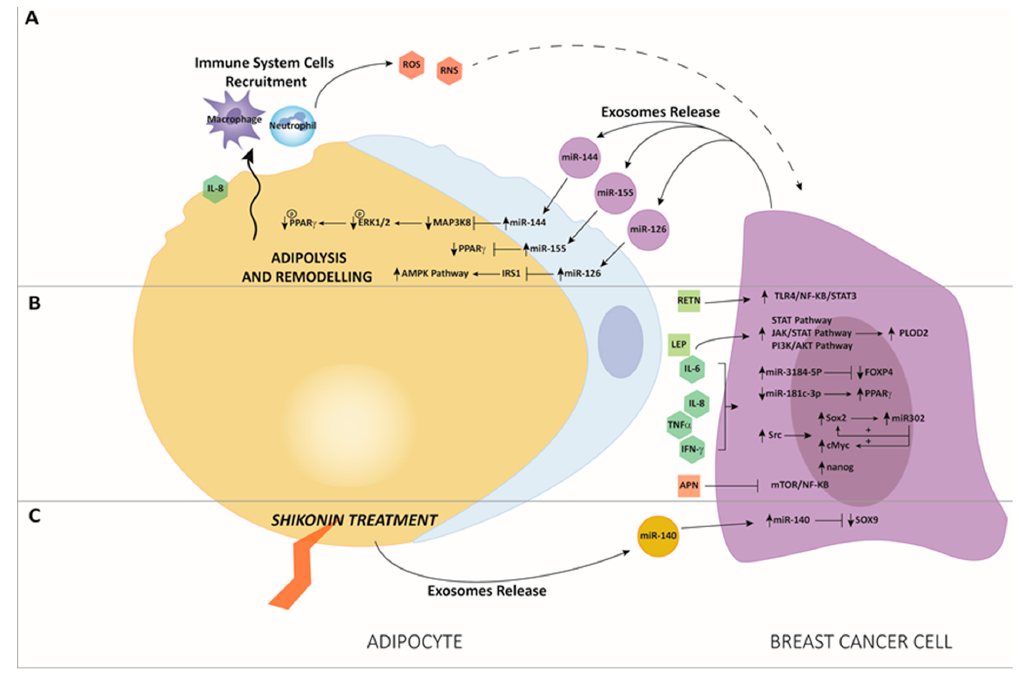
Figure 2. ( A ) After co-culture between adipocytes and breast cancer (BC) cells, high levels of miR-144 and miR-126 were released by exosomes by BC cells. This miRs delivery leads to final adipolysis and remodeling of adipose tissue driven by miR-144 through the downregulation of Mitogen-Activated Protein Kinase Kinase Kinase 8 / Mitogen-Activated Protein Kinase 3 / 1 / Peroxisome Proliferator Activated Receptor Gamma (MAPK3 / ERK1 / 2 / pPPAR γ ) and by miR-126 through the Protein Kinase AMP-Activated Catalytic Subunit Alpha 1 (AMPK) / autophagy pathway, causing adipocyte-induced tumor growth [77]. BC-derived exosomes after adipocytes interaction carry a higher level of miR-155, which promotes adipocytes di ff erentiation and remodeling in surrounding adipocytes targeting pPPAR γ , thus facilitating tumor progression [76]. Increased adipocyte-derived interleukin-8 (IL-8) is responsible for neutrophils and macrophages recruitment, leading to the production of Reactive Oxygen Species (ROS) and Reactive Nitrogen Species (RNS), which act as a threat to tumor initiation. ( B ) Interaction of adipocytes with BC cells increase the release of proinflammatory cytokines and chemokines, leading to an upregulation of miR-3184-5p and downregulation of miR-181c-3p in BC cells, with the modulation of their respective target genes, forkhead box P4 (FOXP4) and PPAR α ; increased release of adipocyte-derived proinflammatory cytokines and adipokins such as leptin (LEP), IL-6, IL-8 and tumor necrosis factor alpha (TNF α ) is responsible for the induction of janus kinase / signal transducers and activators of transcription (JAK / STAT) and through phosphoinositide 3-kinase / protein kinase B (PIK3 / AKT) pathways. Resistin (RETN) promotes BC progression through the Toll like receptor 4 / nuclear factor kappa-light-chain-enhancer of activated B cells / signal transducer and activator of transcription 3 (TLR4 / NF- κ B / STAT3) axis. As a result, EMT, migration and invasion pathways are enhanced in BC cells [72]. Likewise, after adipocytes and BC cells co-culture, there is an increase of proinflammatory cytokines secretion, with an activation of Src that upregulates SRY-Box transcription factor 2 (SOX2), cMYC and Nanog. SOX2 induces miR-302b transcription that, in turn, further stimulates cMYC and SOX2 expression, increasing the cytokine-induced cancer stem cell-like properties [73]. Conversely, adiponectin (APN) has anti-tumoral properties by inhibiting mammalian target of rapamycin (mTOR) and NF- κ B pathways. ( C ) Treatment with the anti-tumor compound shikonin (SK). SK-treated adipocytes release high levels of miR-140, which block tumor progression of co-cultured BC cells targeting SOX9 signaling